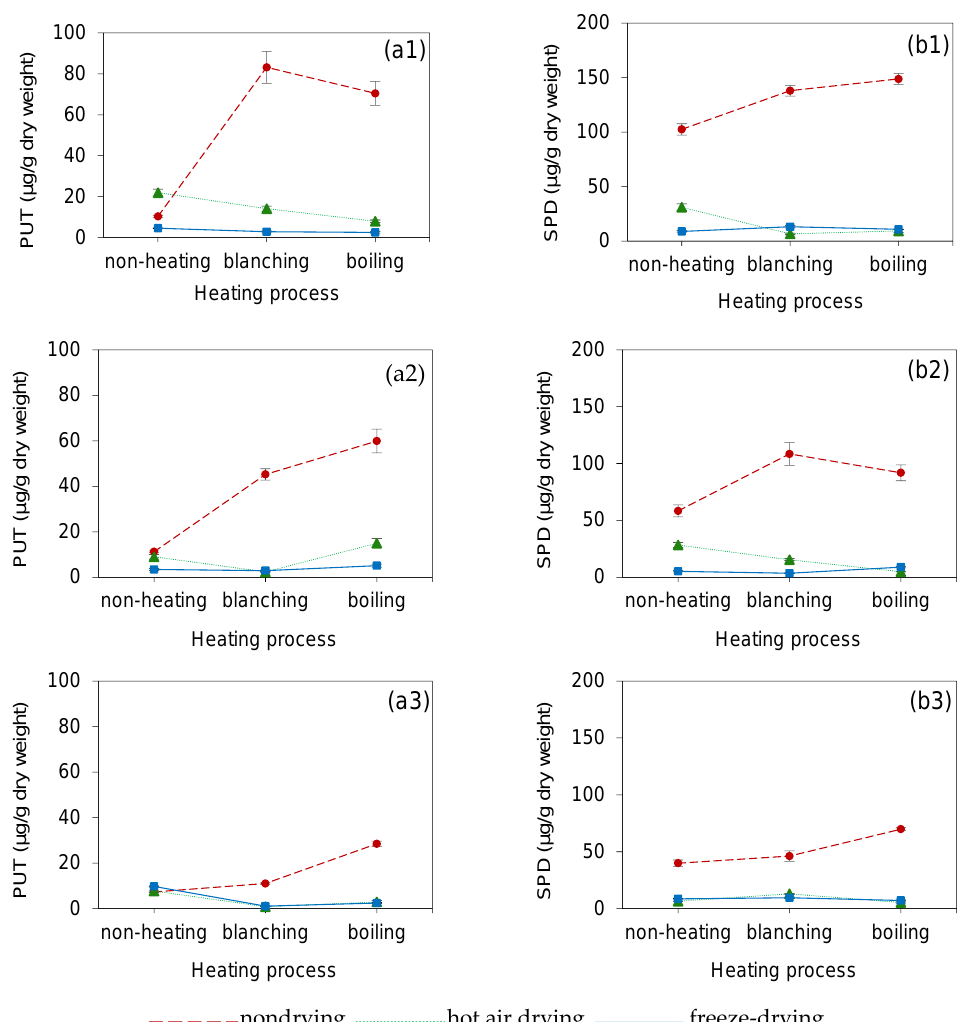
Figure 3. The changes of the PUT content (µg/g of dry weight) in the H. erinaceus extracts from different pretreatment processes: ( a1 ) whole, ( a2 ) ripping, and ( a3 ) chopping and the changes of the SPD content (µg/g of dry weight) in the H. erinaceus extracts from different pretreatment processes: ( b1 ) whole, ( b2 ) ripping, and ( b3 ) chopping.